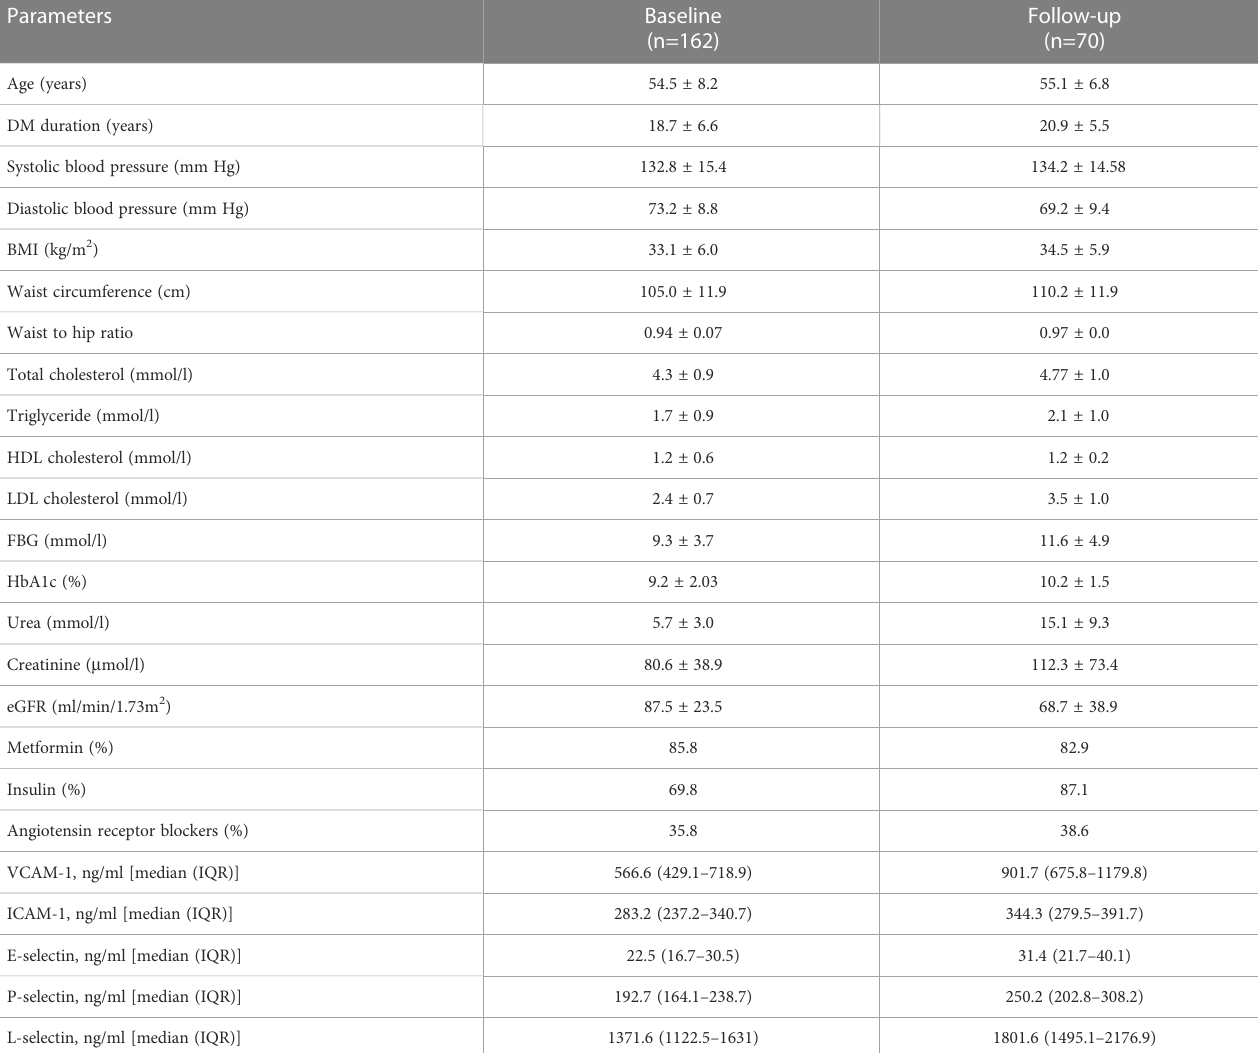
TABLE 1 Demographic and biochemical characteristics of selected study participants at baseline and after 2 years of time